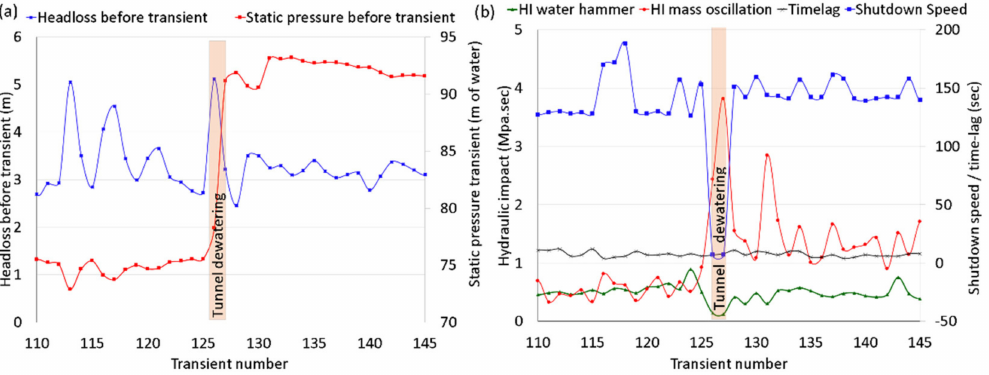
Figure 15. Discharge change magnitude and static pressure before transient for events 110–145 in chronological order ( a ) and corresponding HI for various transients ( b